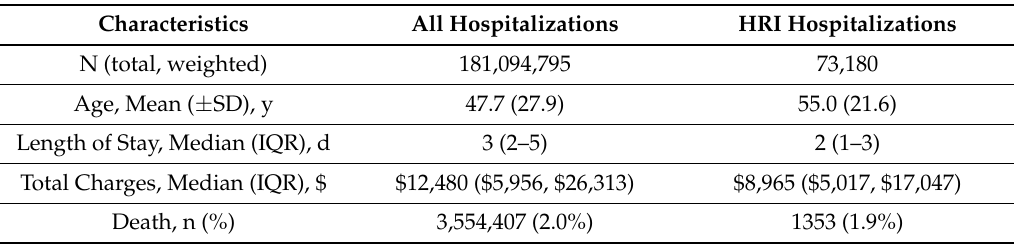
Table 1. Sociodemographic characteristics of patients hospitalized with and without a heat-related illness (HRI), United States 2001–2010